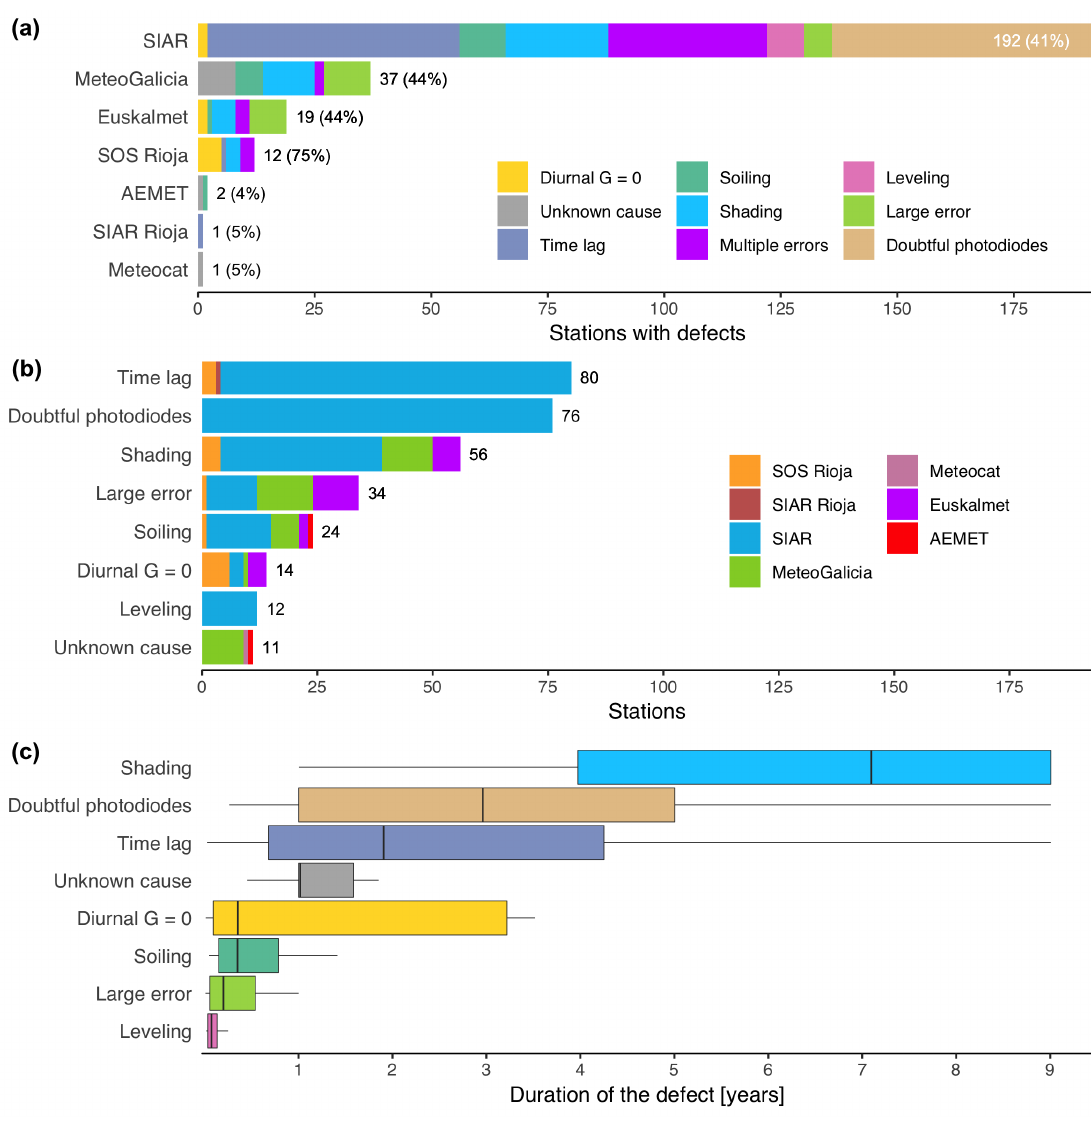
Figure 3. Summary of the defects found at the 732 weather stations. ( a ) Number of defects per network. The “multiple error” group includes those stations with two or more types of defects. The values in brackets show the percentage of stations with defects; ( b ) Number of stations per type of defect. Stations with multiple errors are accounted in all types of defects found; ( c ) Duration of each type of